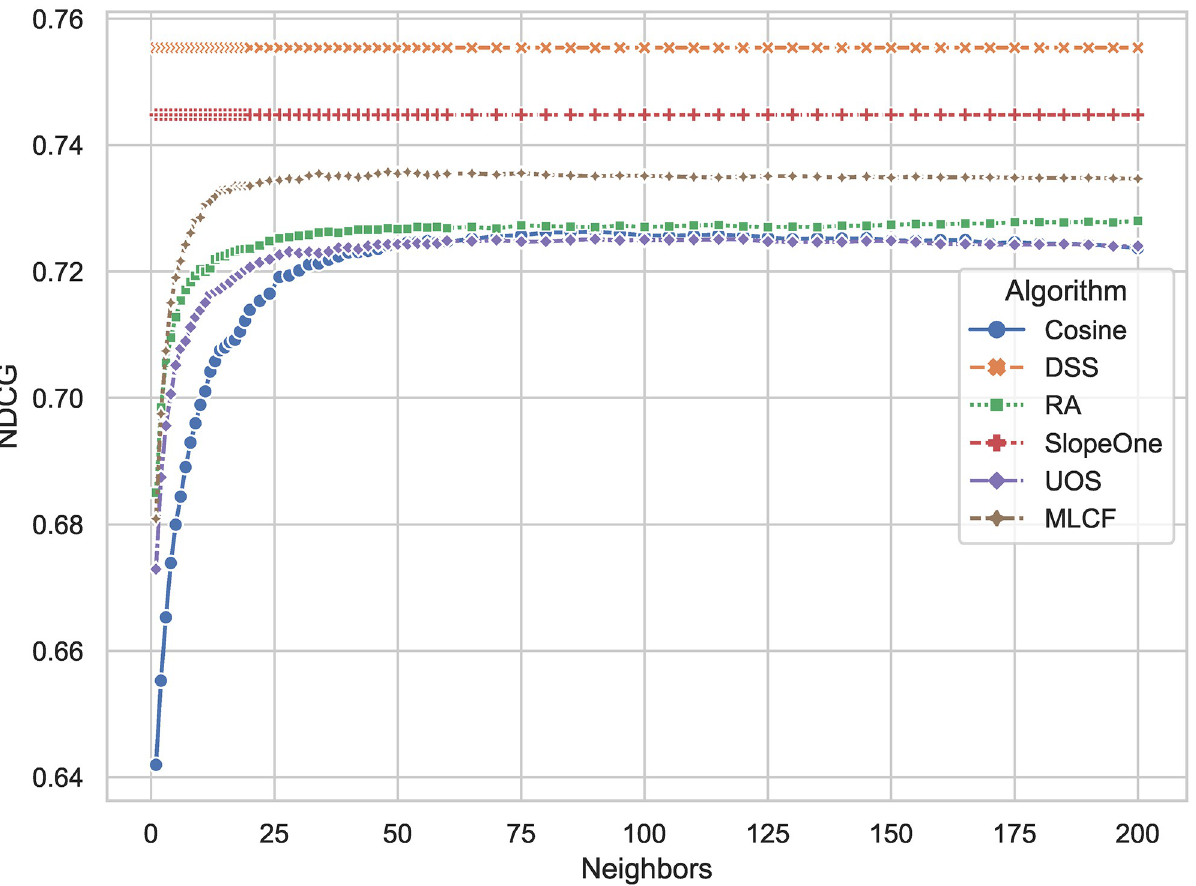
Fig 6. NDCG comparison results of DSS and other algorithms. The larger the result, the higher the probability that the algorithm give a recommendation list with the items that the user likes at the top.